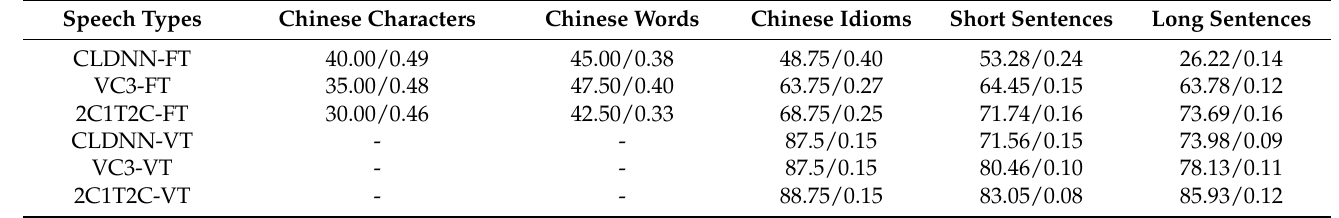
Table 6. Tone accuracy of Mandarin EL speech with different amount of semantic information (average accuracy %/STD) 1